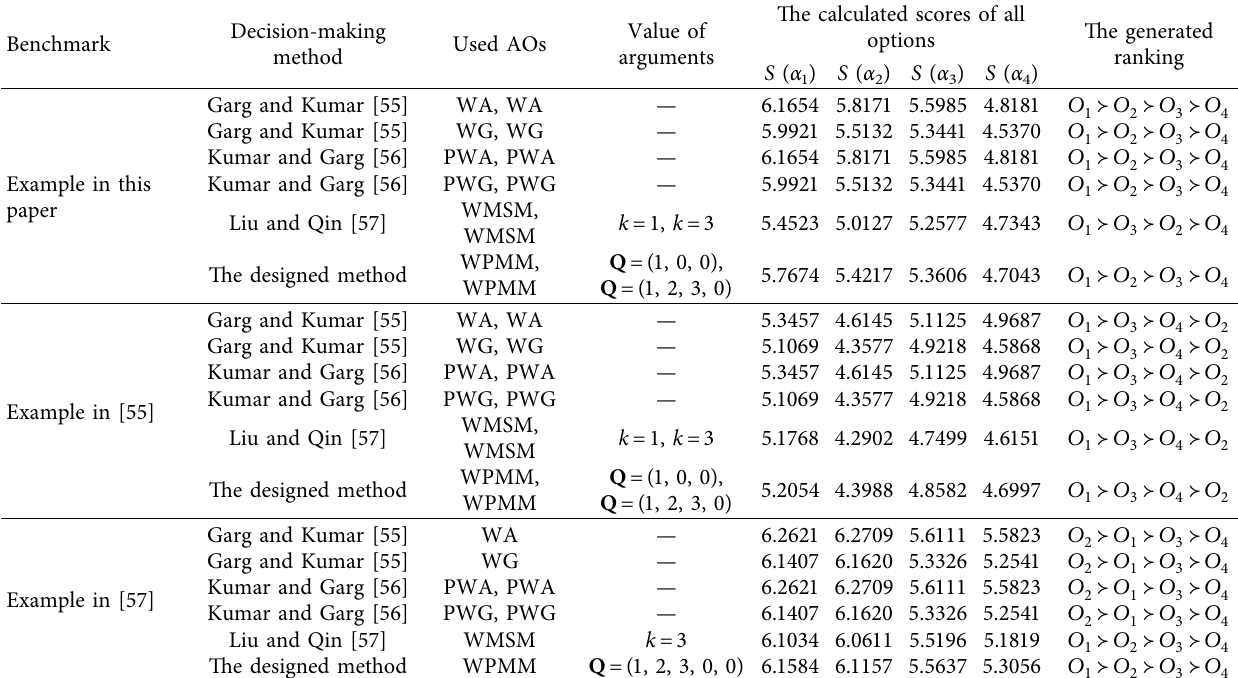
Table 5: The details and results of the quantitative